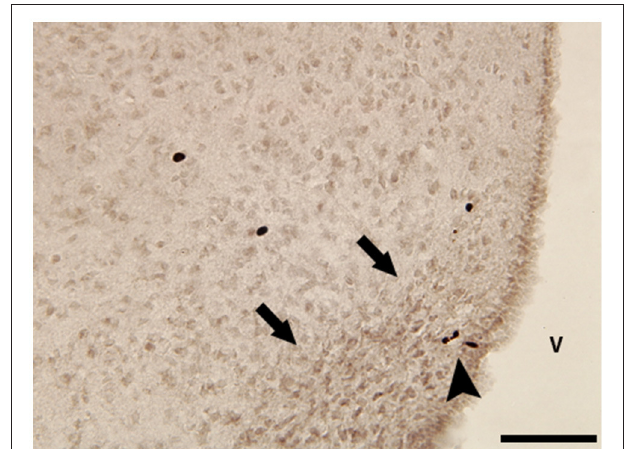
FIGURE 1 | Photomicrograph of BrdU-immunoreactive (ir) cells in the hypothalamus of a subordinate female naked mole-rat collected 2h after a single BrdU injection. Black arrowhead points to small group of BrdU-ir cells within the boundaries of the arcuate nucleus (black arrows). V, 3rd ventricle. Scale bar = 50 µ